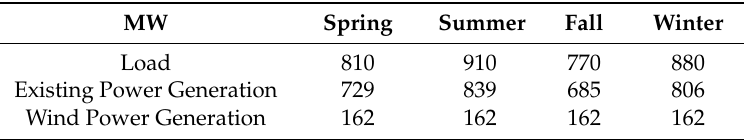
Table 9. Deterministic scenarios for security limit analysis of the Jeju power